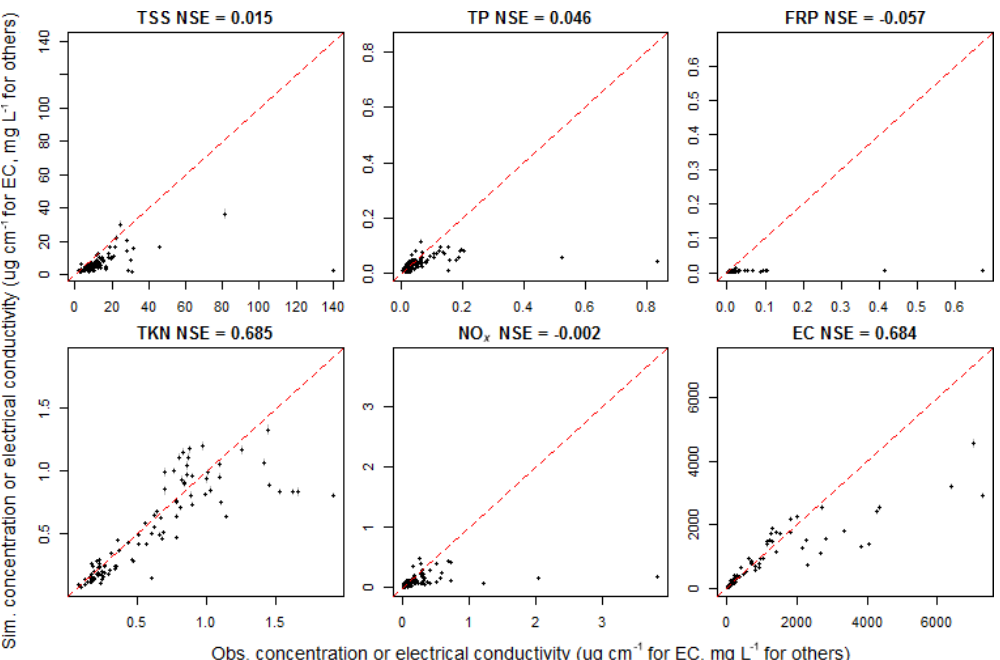
Figure 5. The back-transformation of the model simulations to the measurement scale emphasizes a lack of fit for the highest concentrations, as illustrated by the simulated against observed site-level mean concentrations of each constituent on a back-transformed scale. The 95% upper and lower bounds of all posterior simulations are shown using vertical gray lines. The NSE for each constituent is also shown, and red dashed lines show the 1 : 1